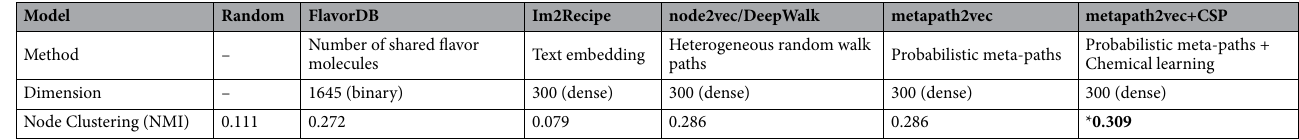
Table 2. Node clustering results. The scores indicate for normalized mutual information (NMI). In the case of FlavorDB, since there is no continuous and dense vector, 1645 binary vectors representing the presence or absence of each chemical compound were used. *We found significant differences among all the results where p < .05 and the number of sampled results ( n = 1000 ).